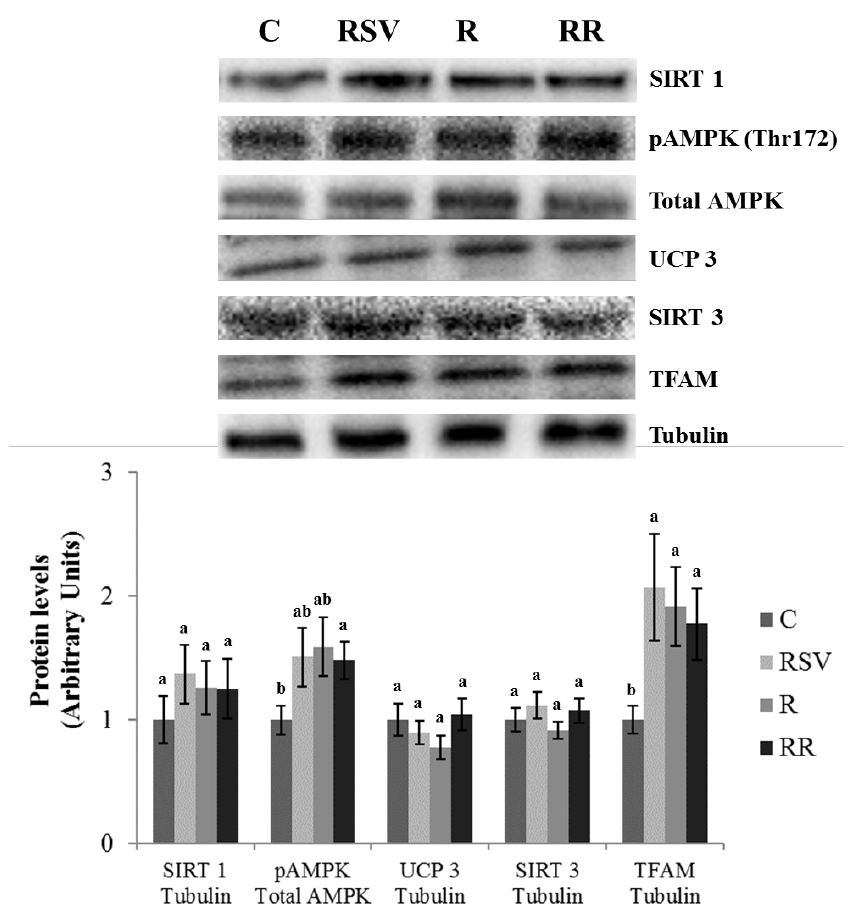
Figure 6. Protein levels of SIRT1, UCP3, SIRT3 and TFAM, and threonine 172 phosphorylation ratio of AMPK in gastrocnemius muscle of rats fed an obesogenic diet for 6 weeks and then shifted to a standard diet (C), or standard diet supplemented with resveratrol (RSV), or submitted to energy restriction and fed a standard diet (R), or submitted to energy restriction and fed a standard diet supplemented with resveratrol (RR) ( n = 9/group) for additional 6 weeks. Values are represented as means ± SEM. Differences among groups were determined by using one-way ANOVA followed by Newman–Keuls post hoc test. Values not sharing a common letter are significantly different ( p < 0.05). SIRT1: sirtuin 1, UCP3: uncoupling protein 3, SIRT3: sirtuin 3, TFAM: mitochondrial transcription factor 1, AMPK: AMP activated protein